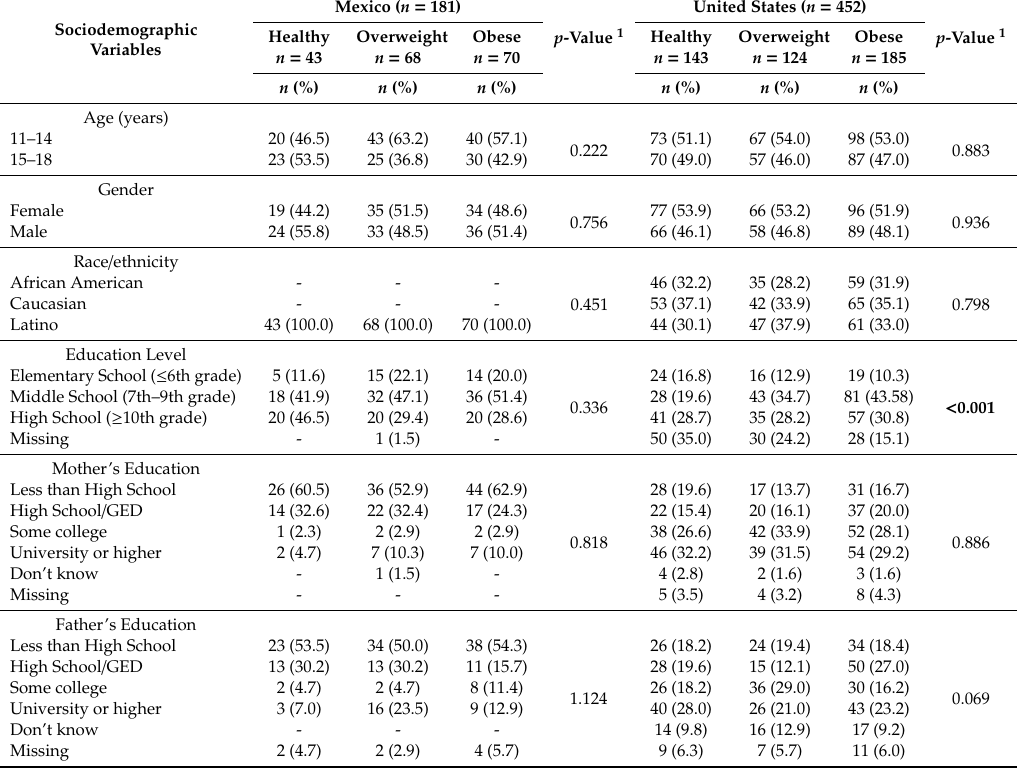
Table 1. Sample characteristics by body mass index (BMI) categories and country ( n =